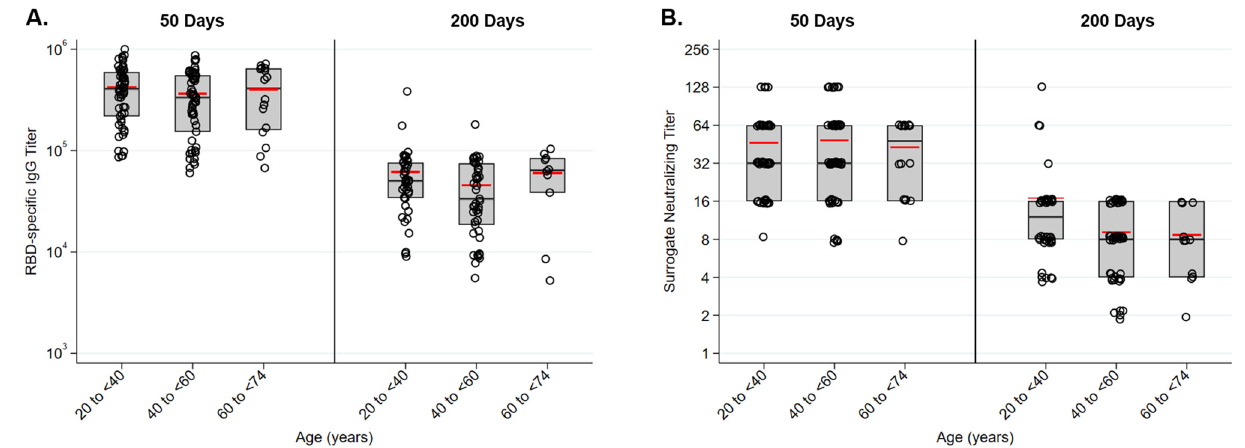
Figure 5. Antibody response to vaccination were similar across age groups. ( A ) RBD-specific IgG titers as measure by ELISA were similar in 20 to <40, 40 to <60, and 60 to <74 age groups. ( B ) SARS- CoV-2 surrogate neutralizing titers were similar 20 to <40, 40 to <60, and 60 to <74 age groups.